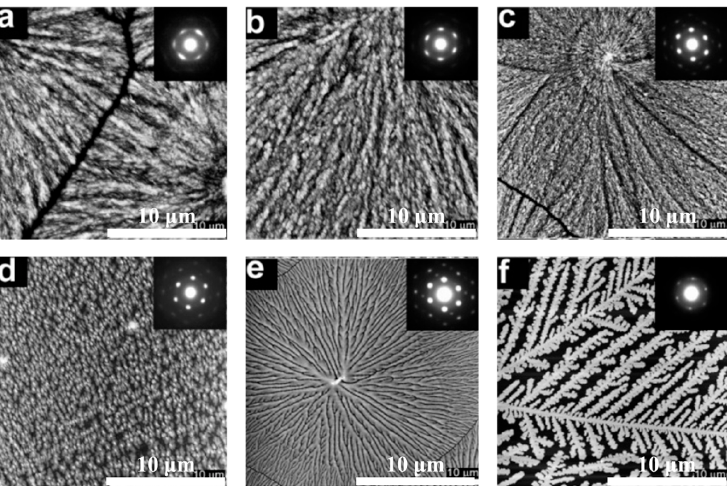
Figure 2. Tapping-mode (TM)-AFM height images (20 μ m × 20 μ m) of poly( ε -caprolactone) (PCL) thin films crystallized for 24 h at room temperature at a film thickness of: ( a ) 200; ( b ) 120; ( c ) 60; ( d ) 30; ( e ) 15; and ( f ) 6 nm. Insets show the corresponding electric diffraction (ED) patterns for the selected area [61]. Scale bar: 10 μ m. Copyright 2005. Reproduced with permission from the American Chemical Society.